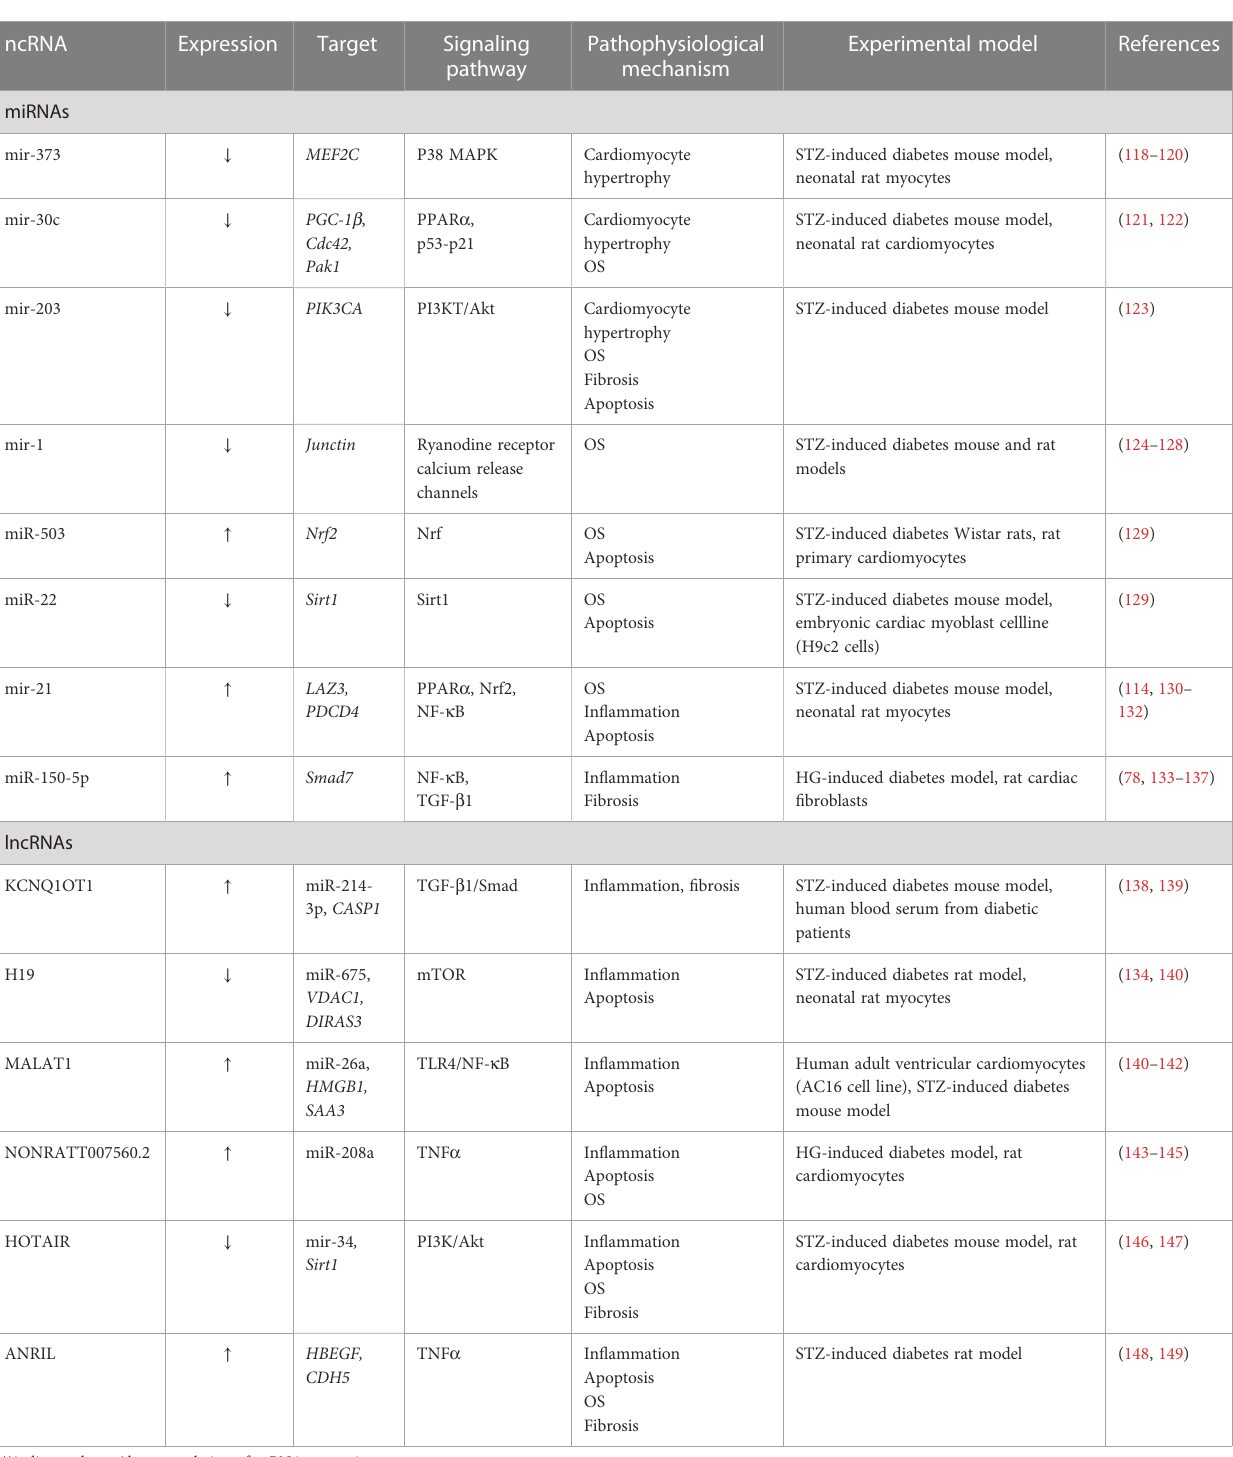
TABLE 1 The roles of miRNAs and lncRNAs in